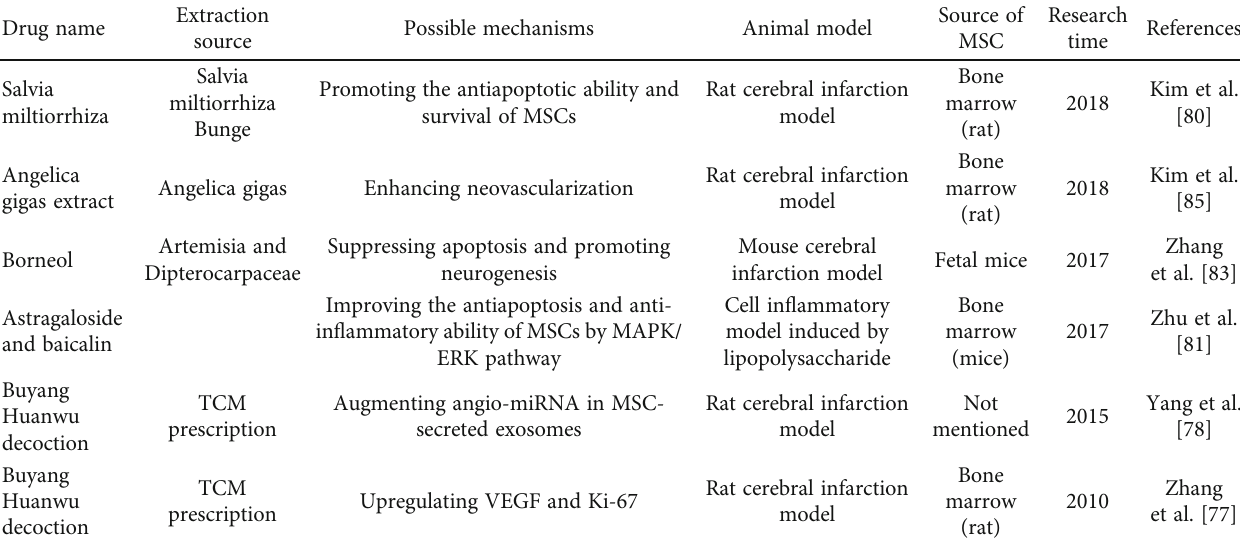
Table 3: Recent studies reporting TCM and extracts that can improve the e ffi ciency of MSC transplantation in ischemic stroke models. Drug